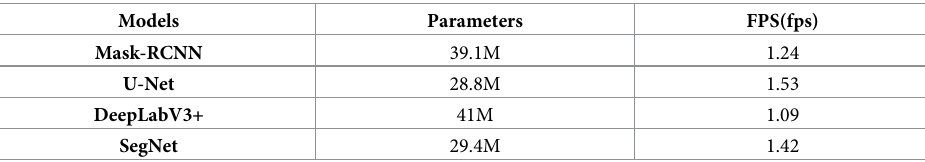
Table 4. The running time of different methods in segmenting